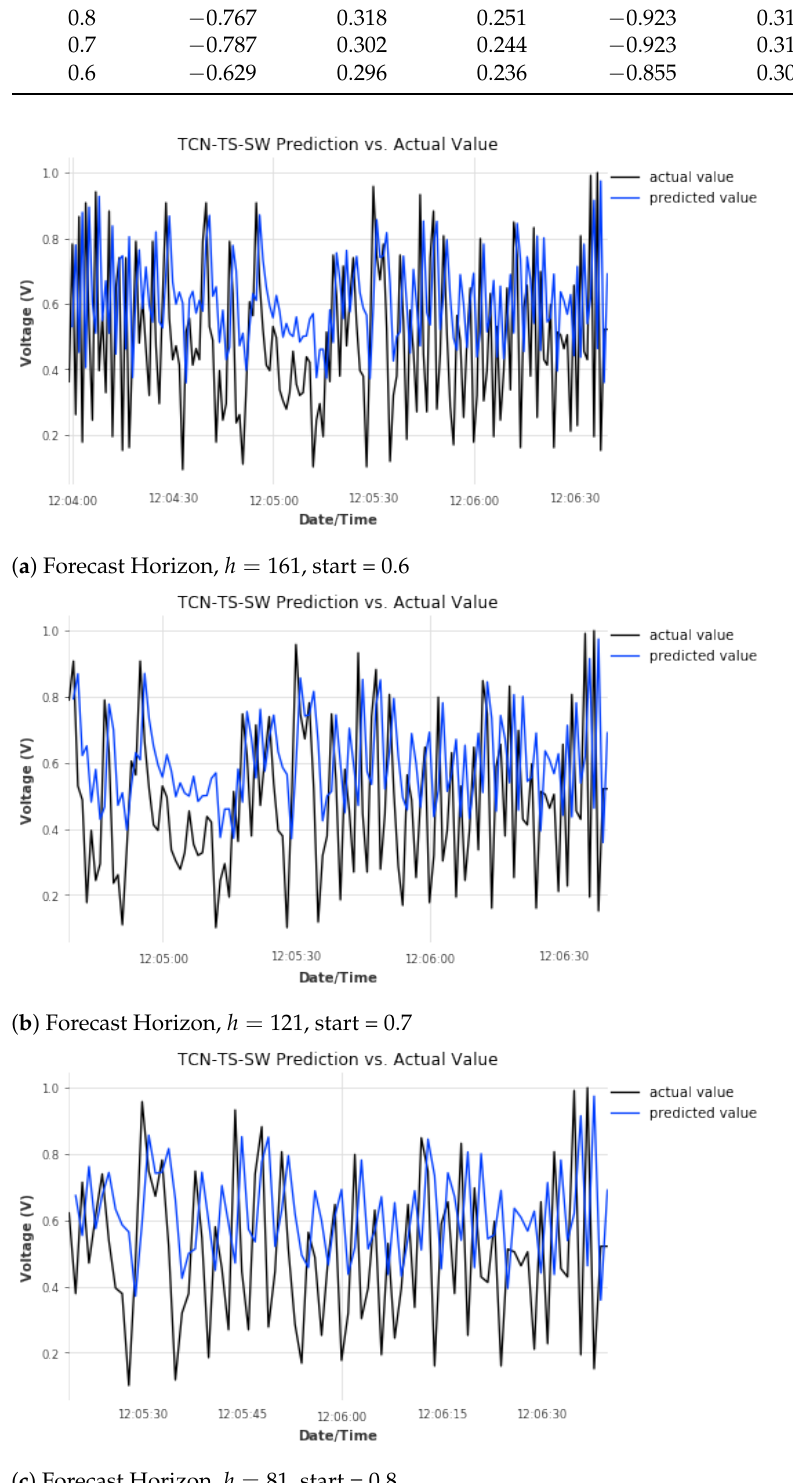
Figure 7. The plotted result between the actual and predicted values. The network has a ∆ = 400 with a training/validation ratio of 70/30. The x-axis represents the time of the execution, and the y-axis represents the voltage (Volts) that represents the raw readings from the temperature